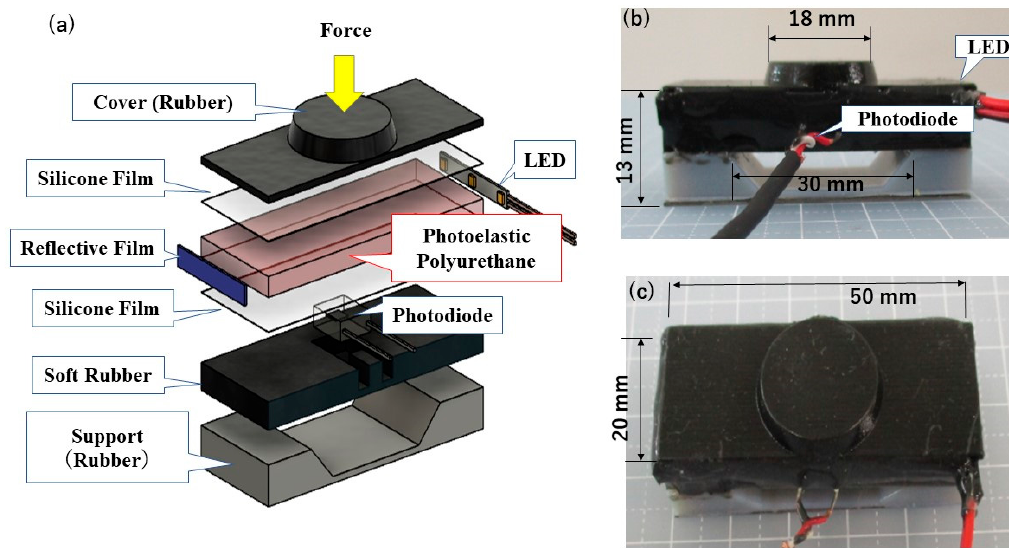
Figure 4. Structure of load sensor functioning on the basis of light leakage due to bending: ( a ) structural drawing, ( b ) side view of sensor, and ( c ) top view of sensor.